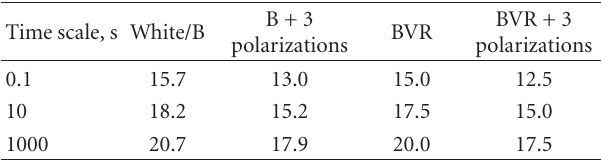
Table 4: Detection limits (in stellar magnitudes) of a basic 3 × 3 unit in narrow-field follow-up mode for a di ff erent combinations of color and polarimetric filters in